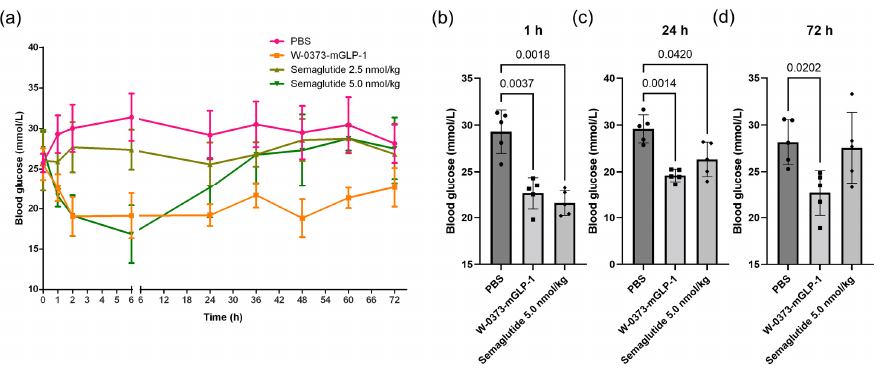
Figure 4. E ff ects of single dose administration of W-0373-mGLP-1 on non-fasting blood glucose in db/db mice. ( a ) Non-fasting blood glucose within 72 h following a single dose and at corresponding ( b ) 1, ( c ) 24, and ( d ) 72 h. All data are represented as mean ± SD.